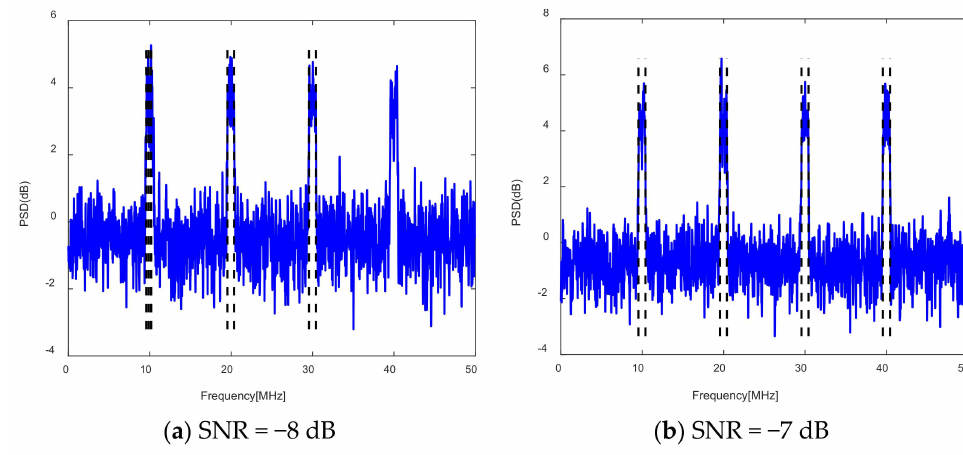
Figure 8. LAD ACC detection at different SNR values.